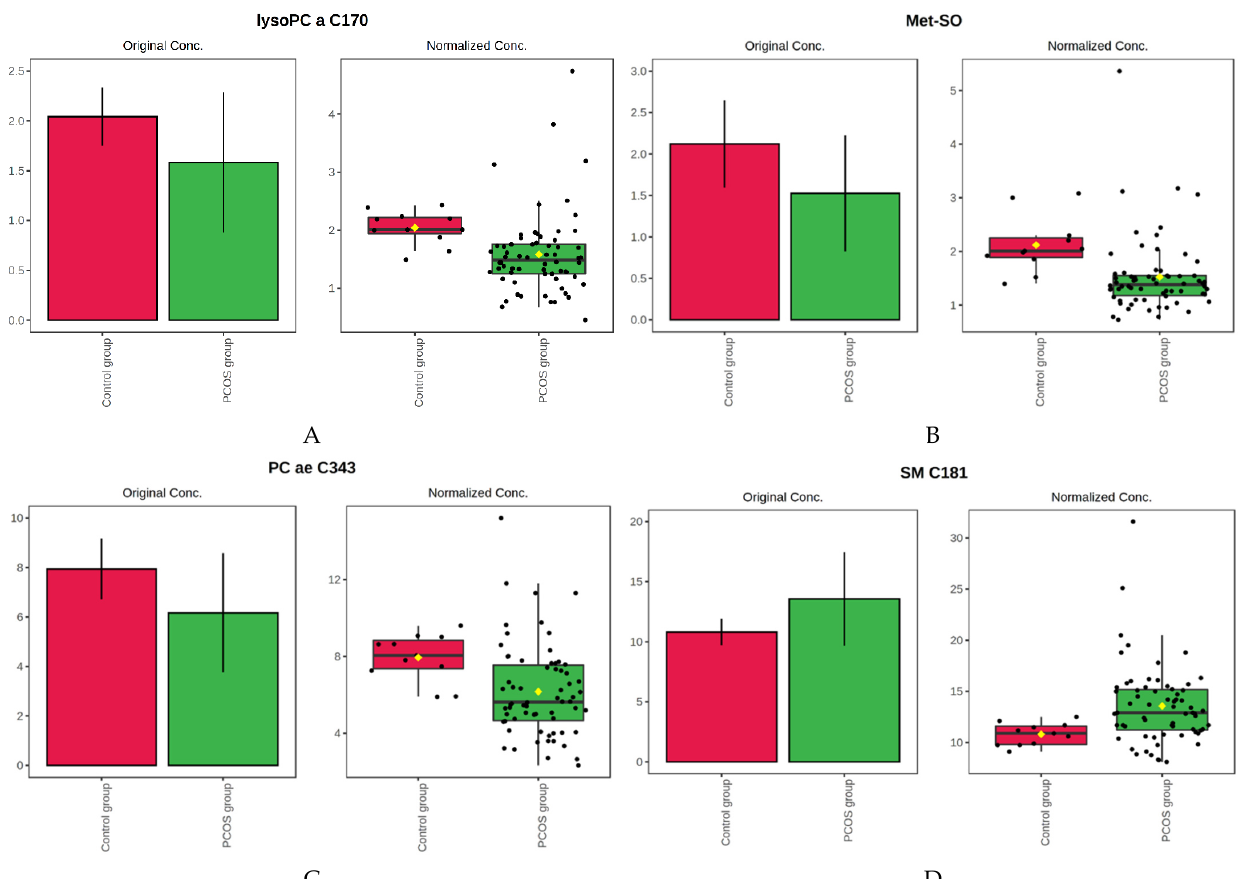
C D Figure 4. Box plots showing distributions of the selected metabolites across the studied groups. The bar charts on the left show the original values (mean +/ − SD). The box and whisker plots on the right summarize the normalized values. However, since these analyzes are univariate, therefore there was no data normalization. Thus, the original values and normalized values make the same values, only shown in two different types of graphs. ( A ) Lysophosphatidylcholine acyl C 17:0 (lyso PC a C17:0); ( B ) Methionine sulfoxide (Met-SO); ( C ) Phosphatidylcholine acyl-alkyl C34:3 (PC ae C34:3); ( D ) Sphingomyelin C18:1 (SM C18:1). Those results, as well as univariate ROC curve analysis, are demonstrated in Table 4. We used the ROC curve as an indicator of the highest discriminating potential, which we Table 4. List of differentiating metabolites with their serum concentrations determined in the whole PCOS group and control group (mean ± SD, uM) and results from univariate